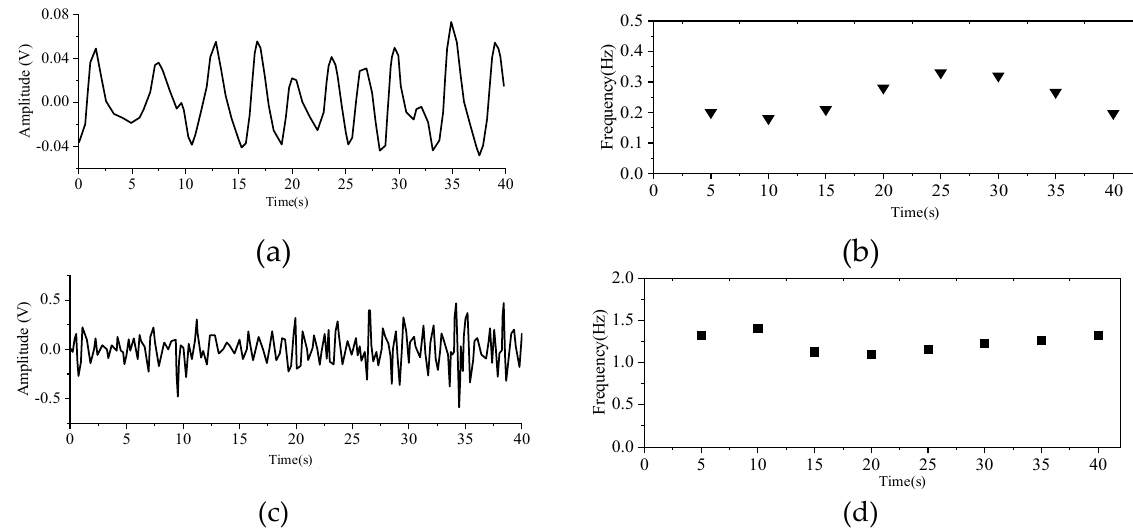
Figure 16. The experimental data. ( a ) Respiratory amplitude diagram, ( b ) Respiratory frequency domain analysis, ( c ) Heartbeat amplitude diagram, ( d ) Heartbeat frequency domain Value Hz.